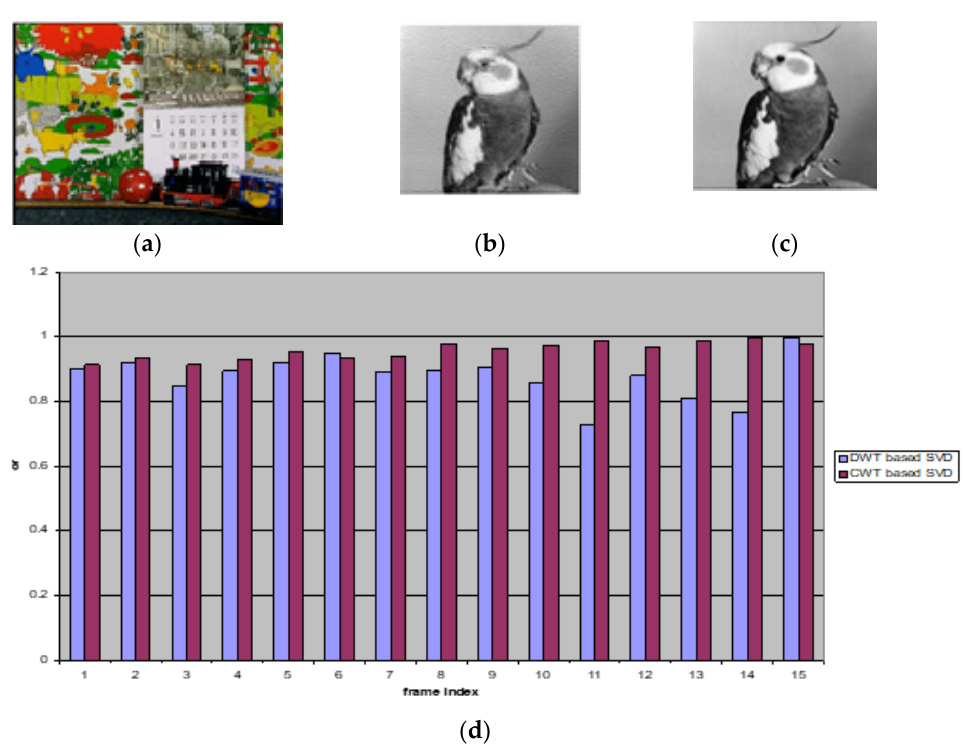
Figure 9. ( a ) The watermarked frame using the proposed method. ( b ) Extracted watermark from frame 10 of the first video scene in the proposed method. ( c ) Extracted watermark from frame 10 of the first video scene in the DWT-based SVD method. ( d ) Correlation values for the extracted watermarks for frames 1 to 15 in the first video scene without attacks.